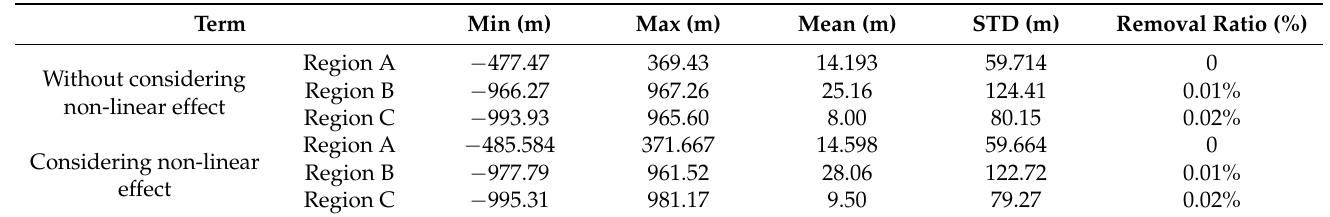
Table 6. Precision comparison between bathymetry inversion results by considering or not consid- ering the non-linear effect.